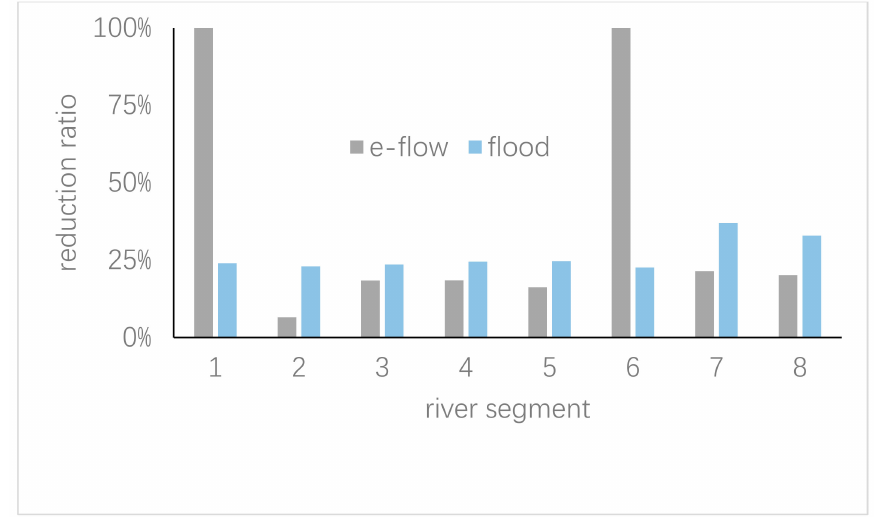
Figure 4. Comparison of reduction ratios between e-flow requirement and flood control ability under the medium hydrological connectivity scenario with a siltation depth equal to 0.5